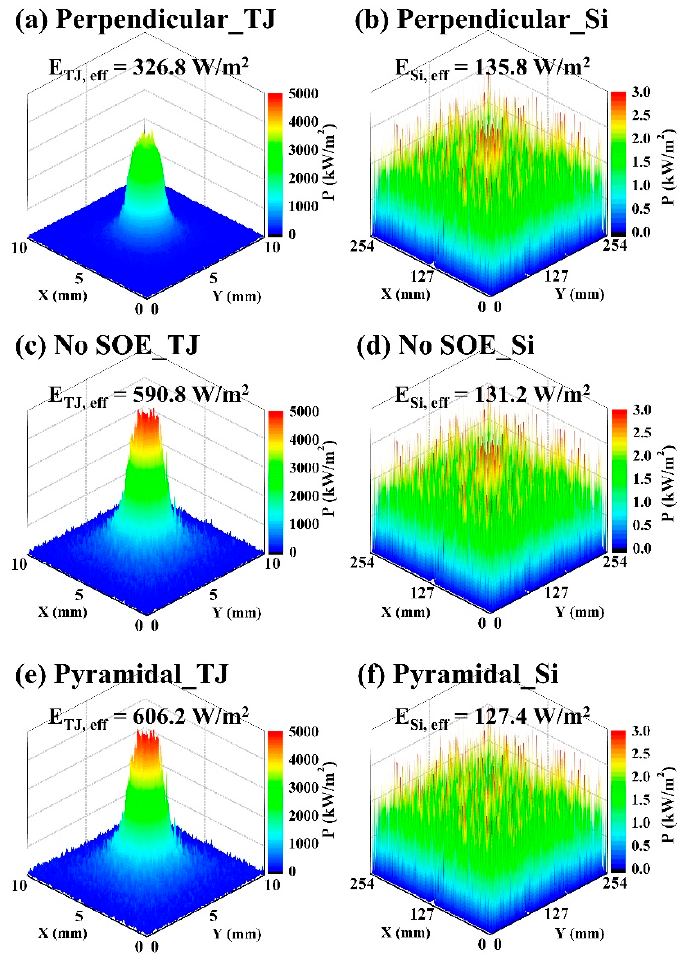
Figure 5. Irradiance distributions of the triple-junction and 12 silicon solar cells with three SOE configurations: ( a , b ) perpendicular ( θ = 0°, h = 15 mm), ( c , d ) no SOE (h = 0), and ( e , f ) pyramidal ( θ = 30°, h = 15 mm).